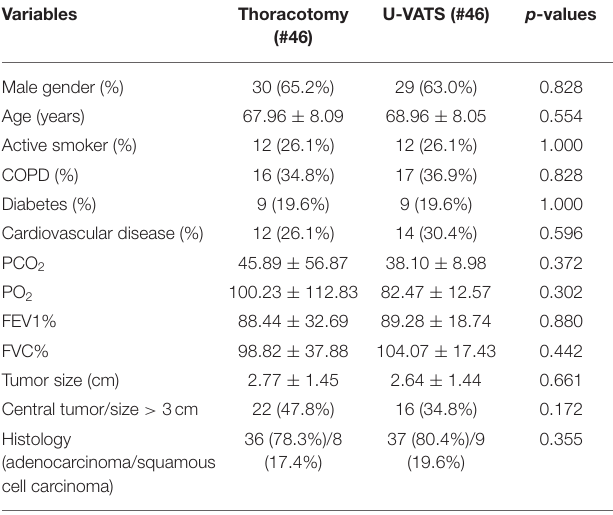
TABLE 2 | Clinical characteristics of the patients after propensity score